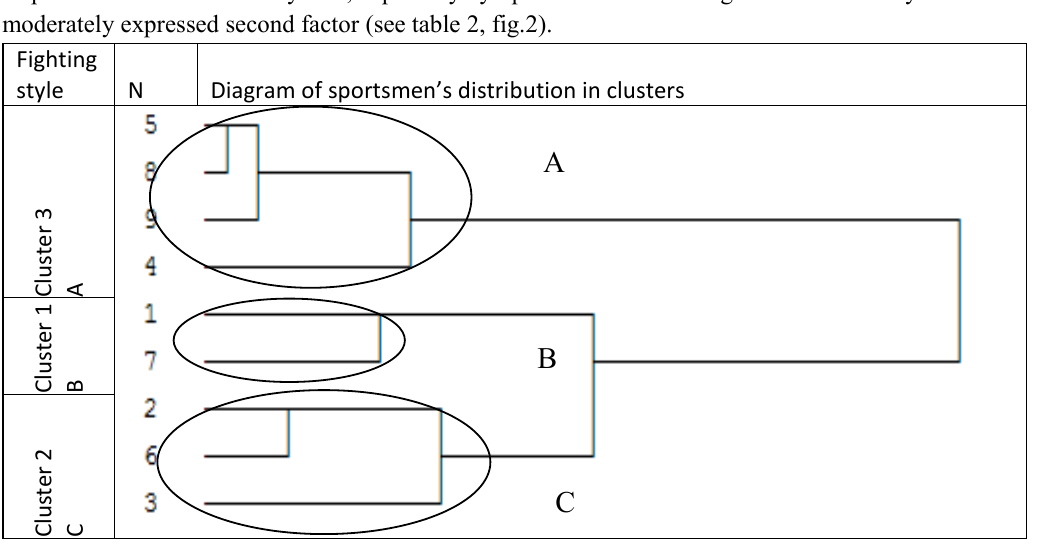
Fig. 1. Diagram of elite judo wrestlers’ distribution in clusters (9 sportsmen were taken as examples): A – judo wrestlers of power fighting style; B – judo wrestlers of variable fighting style; C – judo wrestlers of speed (quick) during long time fighting style; N – number of